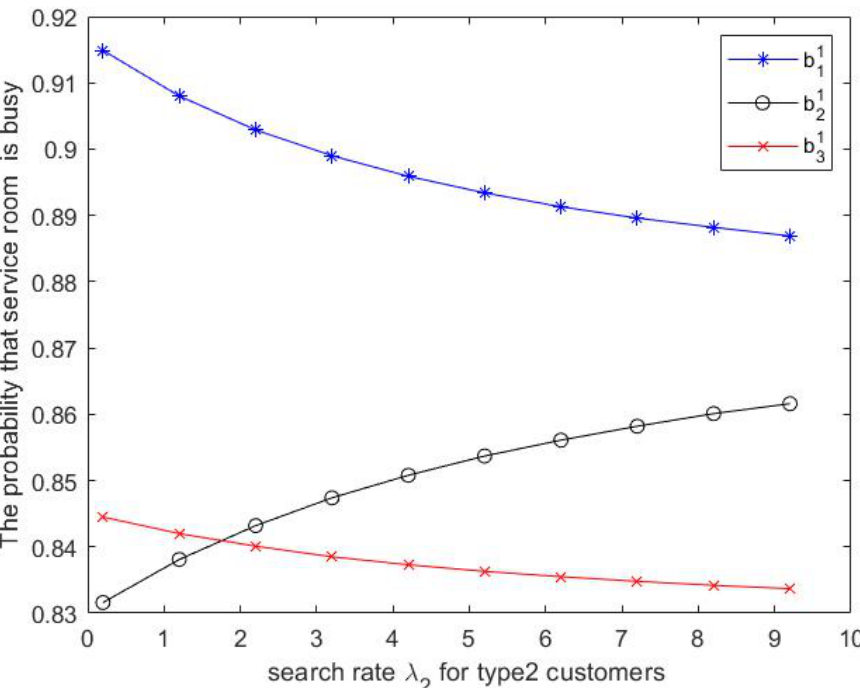
Figure 10. Effect of λ 2 on probability that the service room is